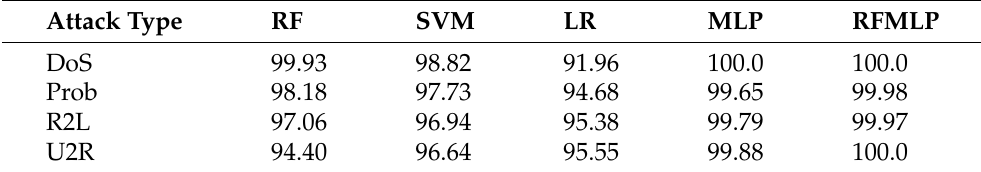
Table 6. Accuracy of classifiers on NSL-KDD dataset.